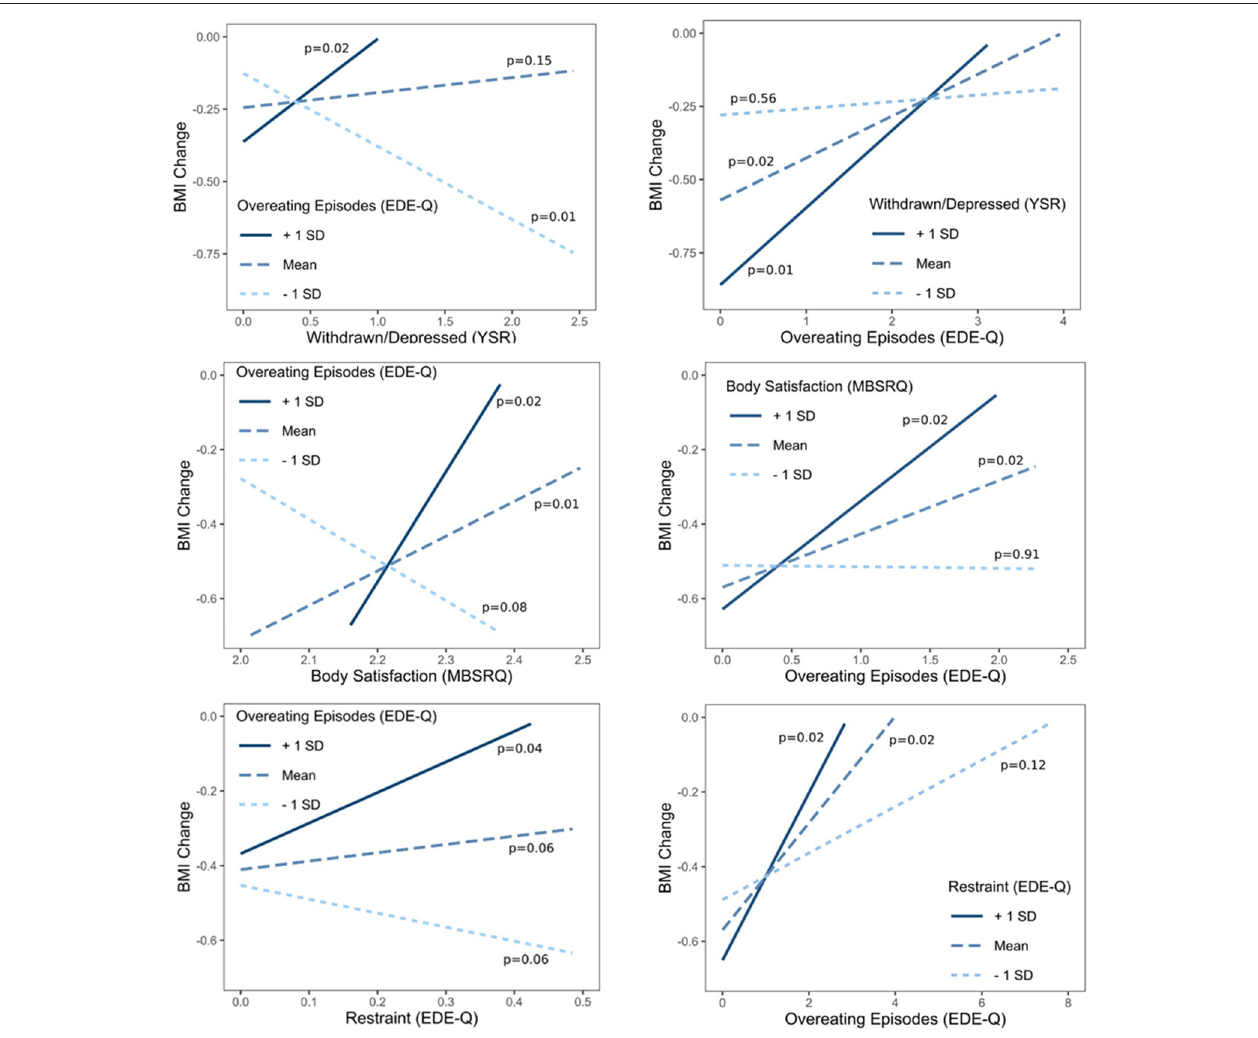
FIGURE 2 | Simple slope analysis for three statistically significant interactions in the multivariate regression model.